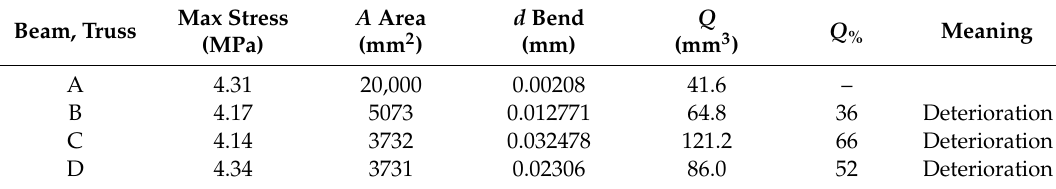
Figure 11. Stress diagram of a simple Michell truss D. Table 1. Comparison of the B, C beams, and D truss to the basic A beam.